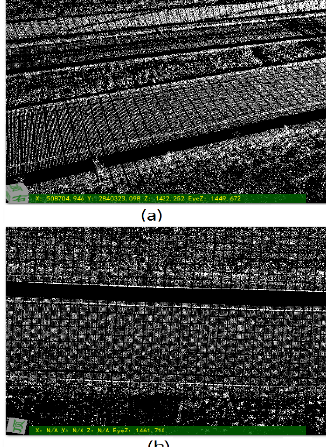
Figure 3, Mesh partition in vehicle-borne coordinate